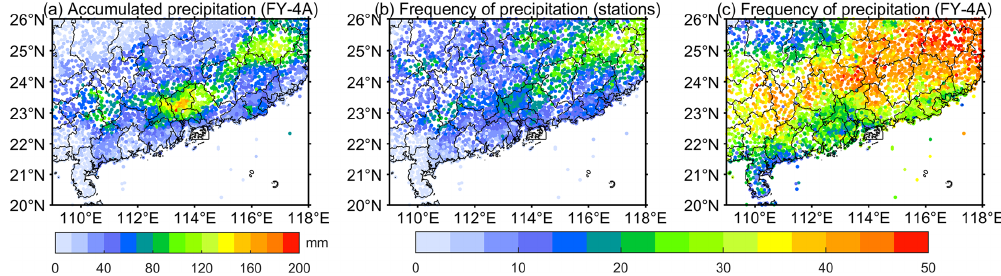
Figure 10. Spatial distribution of accumulated precipitation: (a) accumulated precipitation estimated by the QPE algorithm; (b) actual precipitation frequency observed by high-density automatic stations; (c) precipitation frequency estimated by the QPE